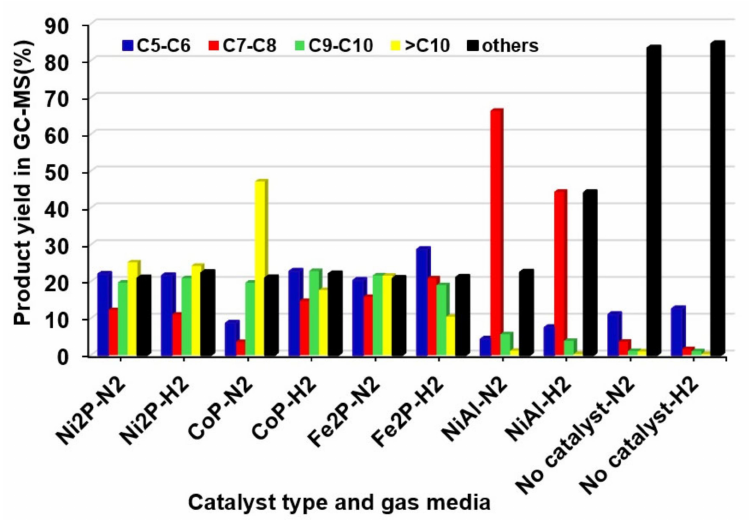
Figure 13. The effects of various catalysts and gas media (N 2 and H 2 ) on HVC yields at reaction conditions of 6 h, 300 ◦ C, 2 bars initial pressure, 5 wt.% catalyst loading with respect to biomass amount, 2 g biomass, methanol solvent, and 180 µ m biomass particle